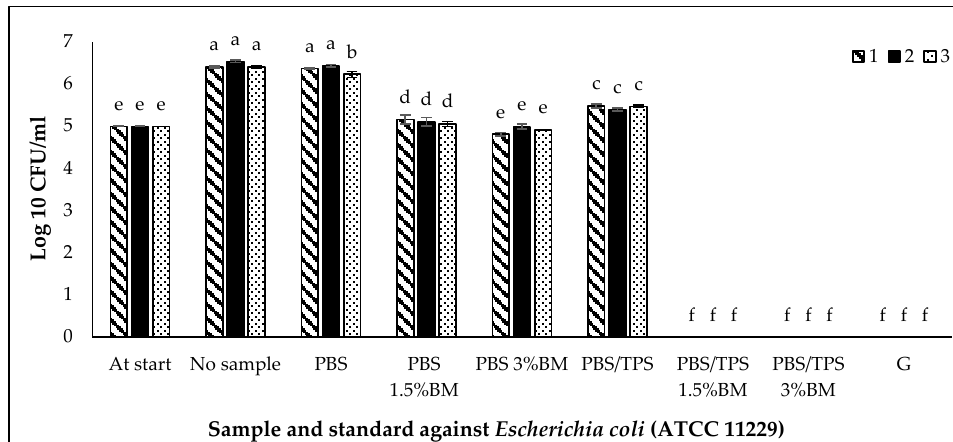
Figure 7. Staphylococcus aureus (ATCC 6538P) growth on different PBS films. Note: At start: the cell number of culture before incubation (5 log CFU/mL); No sample: no PBS film; PBS: PBS film without antimicrobial agent; PBS 1.5% BM: PBS with 1.5% BM; PBS 3% BM: PBS with 3% BM; PBS/TPS: PBS with tapioca starch; PBS/TPS 1.5% BM: PBS/tapioca starch with 1.5% BM; PBS/TPS 3% BM: PBS/tapioca starch with 3% BM; G: Gentamicin. Error bars represent standard deviation (n = 3). The different a–f small letters indicate significant difference ( p < 0.05) among film samples.